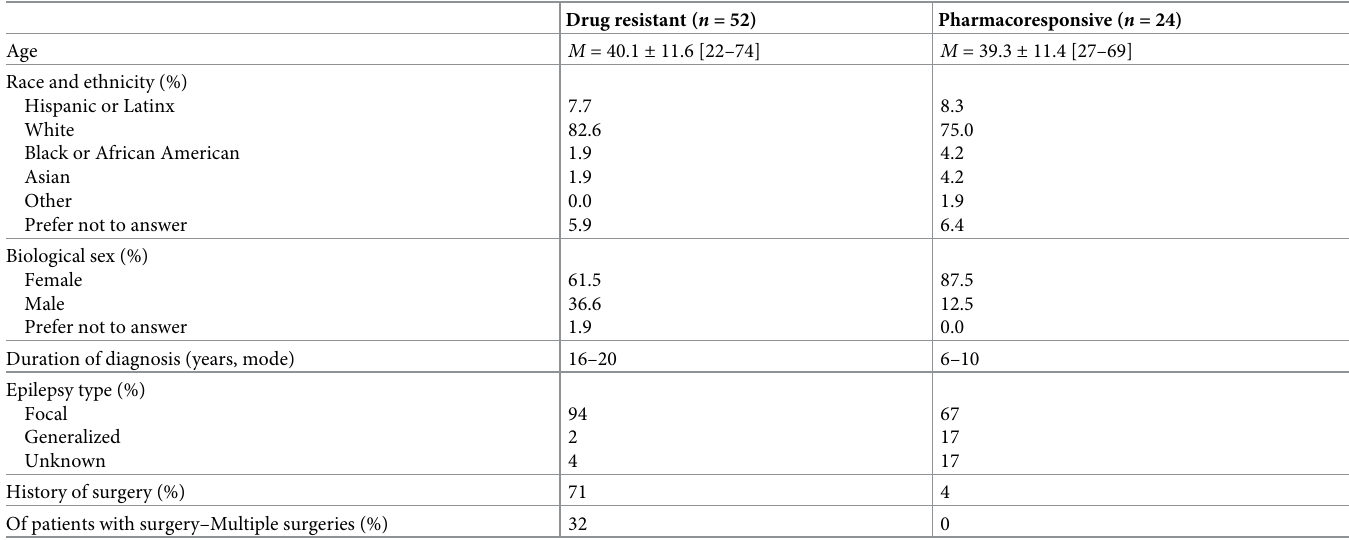
Table 1. Study sample descriptive